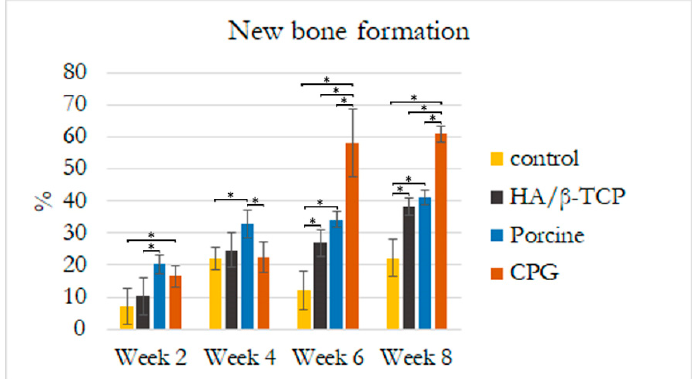
Figure 7. Histological new bone formation percentage at two, four, six, and eight weeks. Bone area